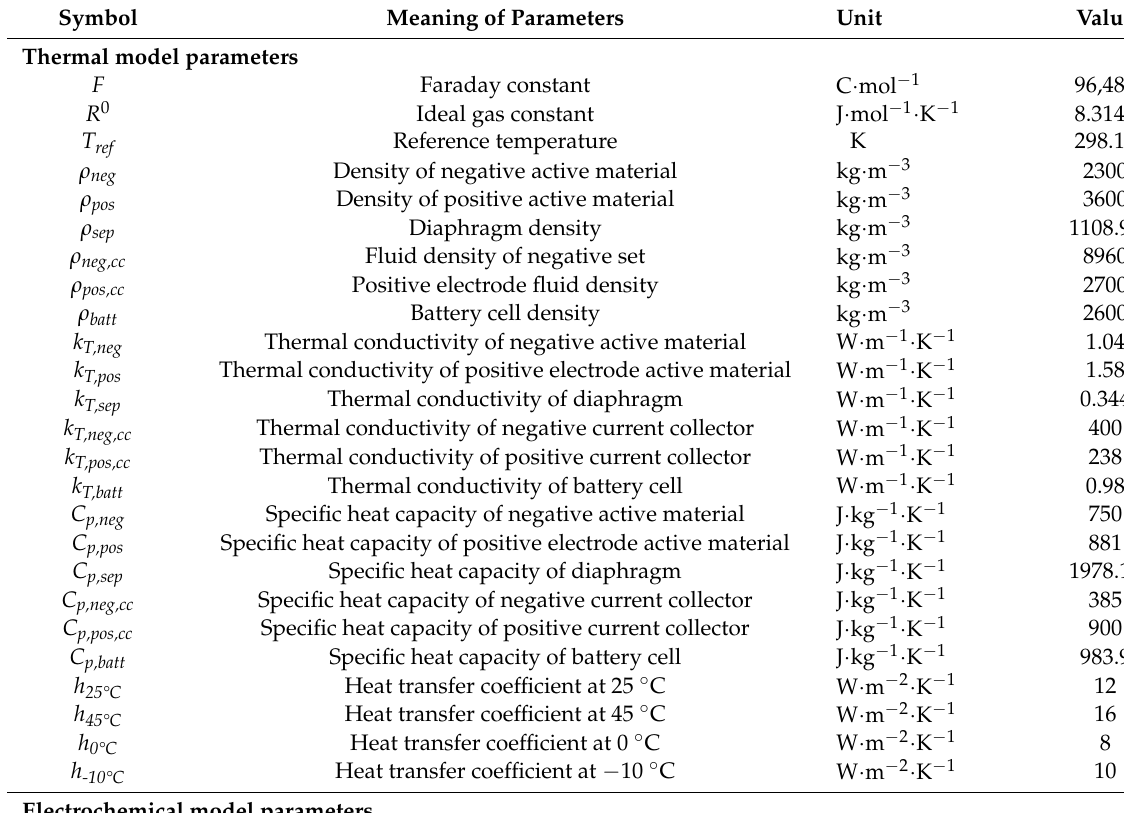
Table 2. Model parameters of electrochemical–thermal coupling mechanism and thermal physical parameters of large-size